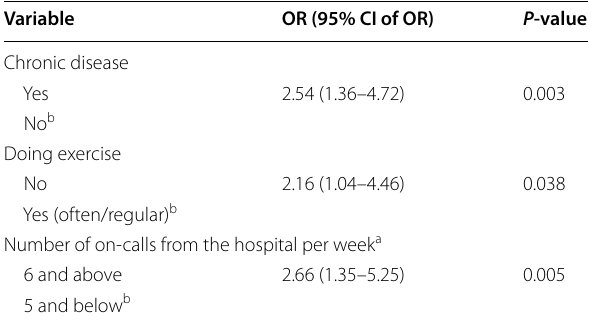
Table 3 Logistic analysis for anxiety in the association of socio‑ demographic and occupational